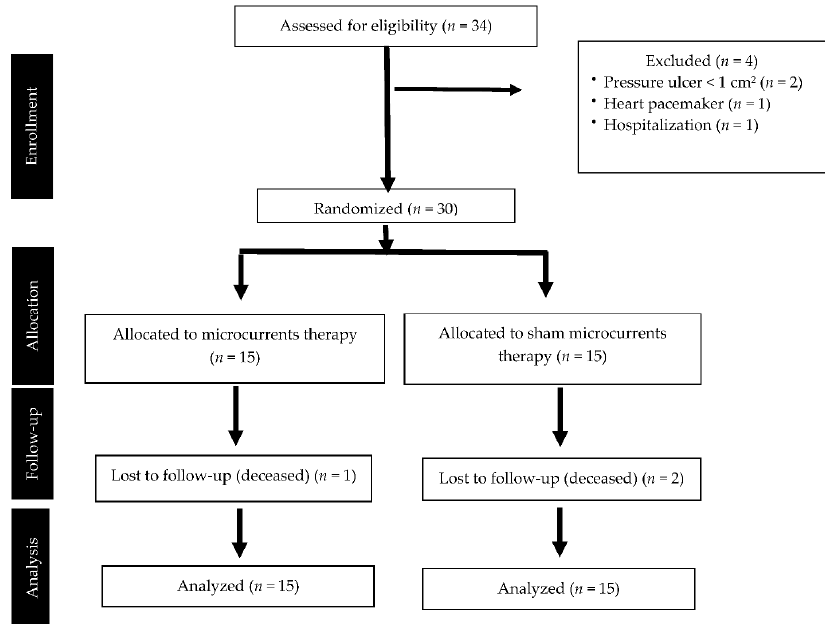
Figure 1. Flow chart of the clinical trial following the CONSORT guidelines.